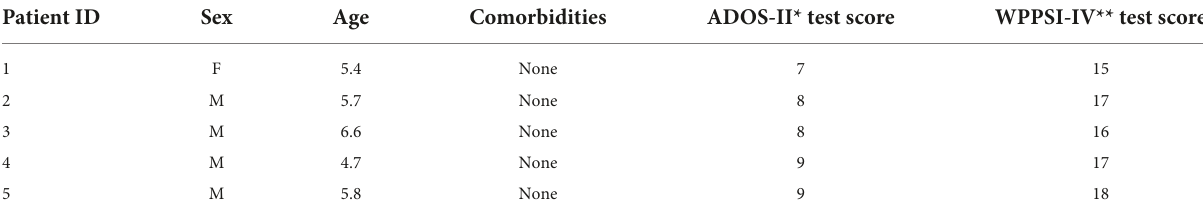
TABLE 1 Demographical and clinical parameters of ASD subjects.